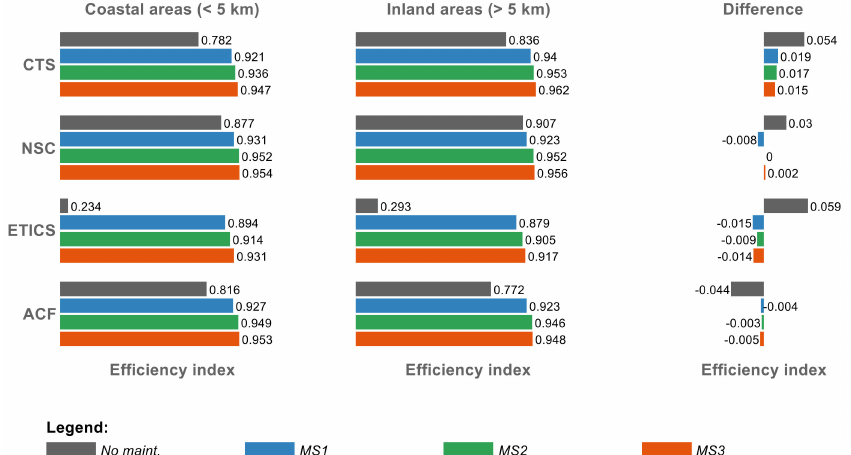
Figure 10. Comparison of the efficiency index according to distance from the sea for a time horizon of 80 years.